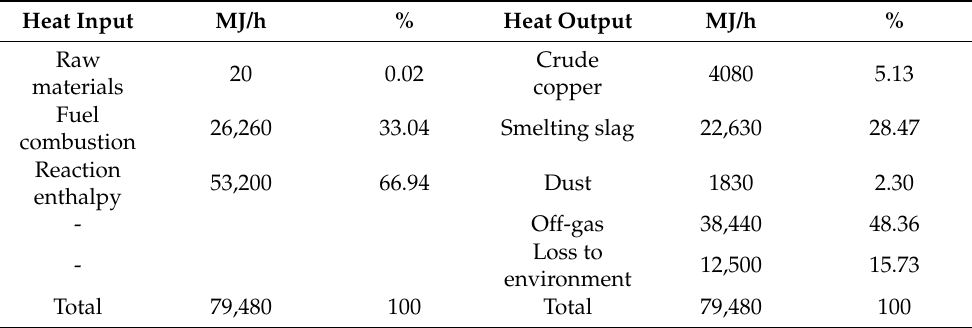
Table 7. The energy balance of E-waste smelting with the NRT